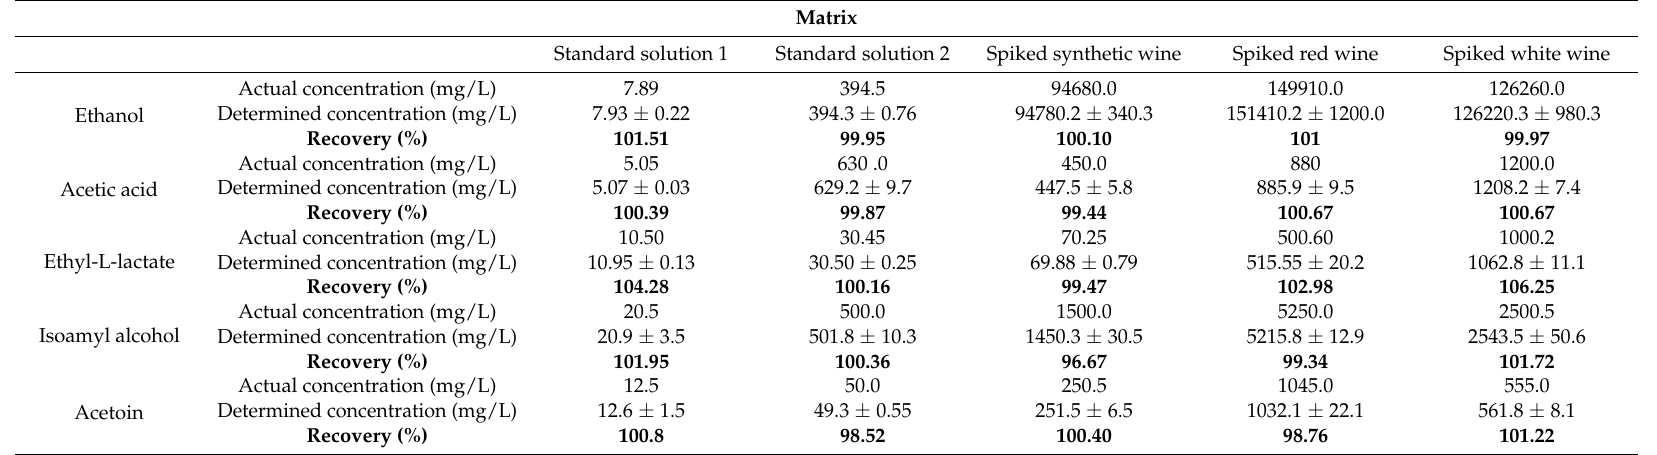
Table 3. The recovery of major volatiles in five different